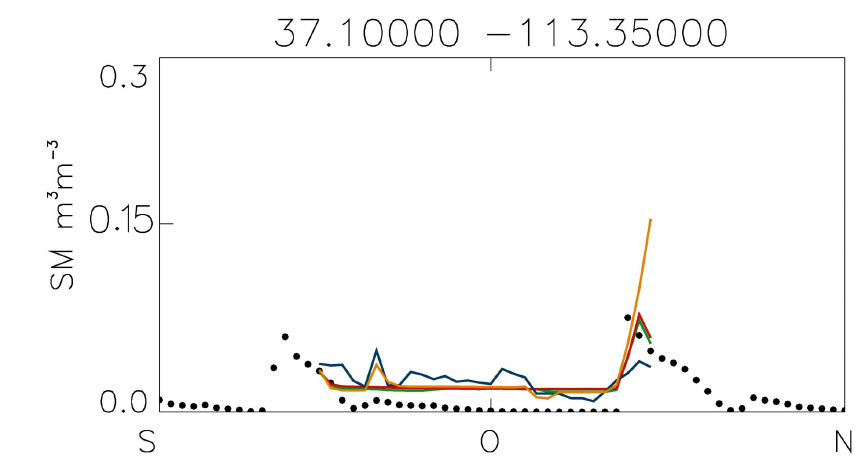
Figure 2. Soil moisture time series for the analyses of OL (red curve) SLV (green curve), SMOS (dark blue curve) and SLV+SMOS (orange curve) experiments. The daily averaged observations for this station of the SCAN network in US are displayed in black dots.